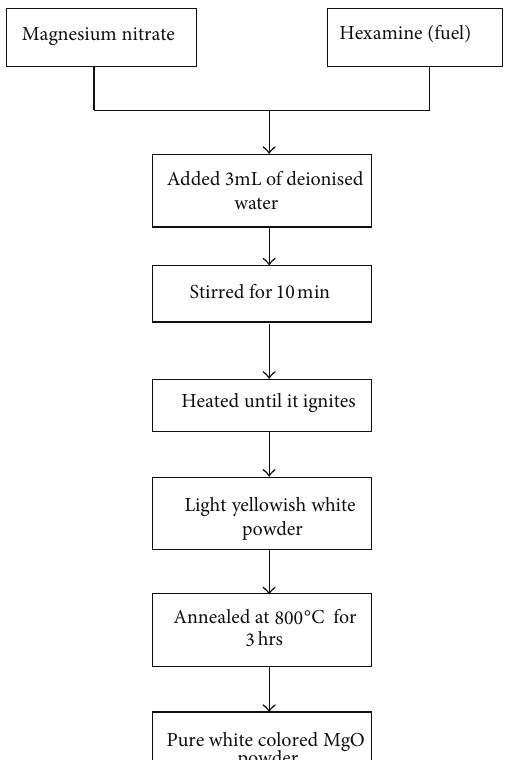
Figure 1: Experimental flow chart for the synthesis of MgO nanopowders by combustion followed by annealing